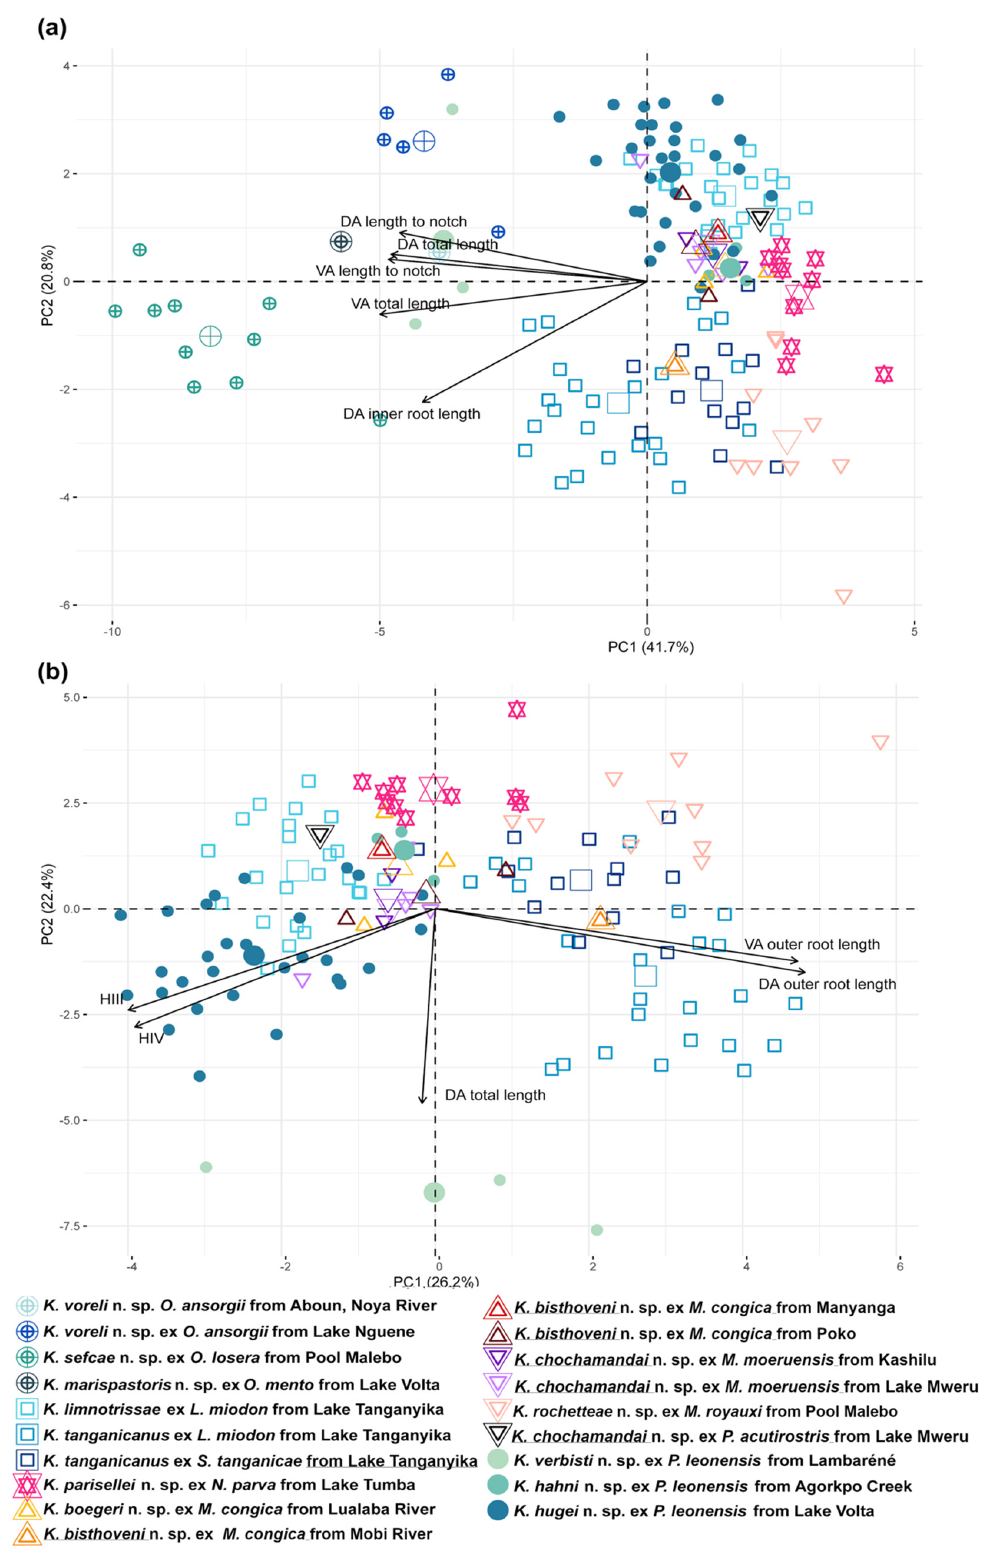
Figure 3. Morphometric variability of haptoral structures of Kapentagyrus spp. ( a ) Biplot of PCA (first two axes) including all species of Kapentagyrus . ( b ) Biplot of PCA (first two axes) excluding species infecting members of Odaxothrissa . Colours and signs denote parasite species, host species, and locality of origin.